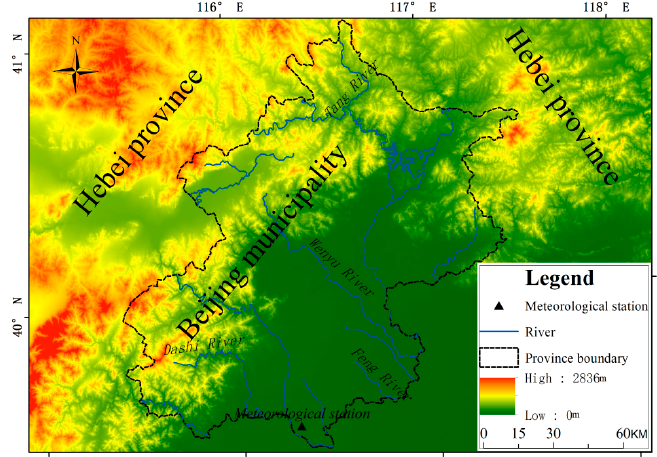
Figure 1. Topographic map of the Beijing area.